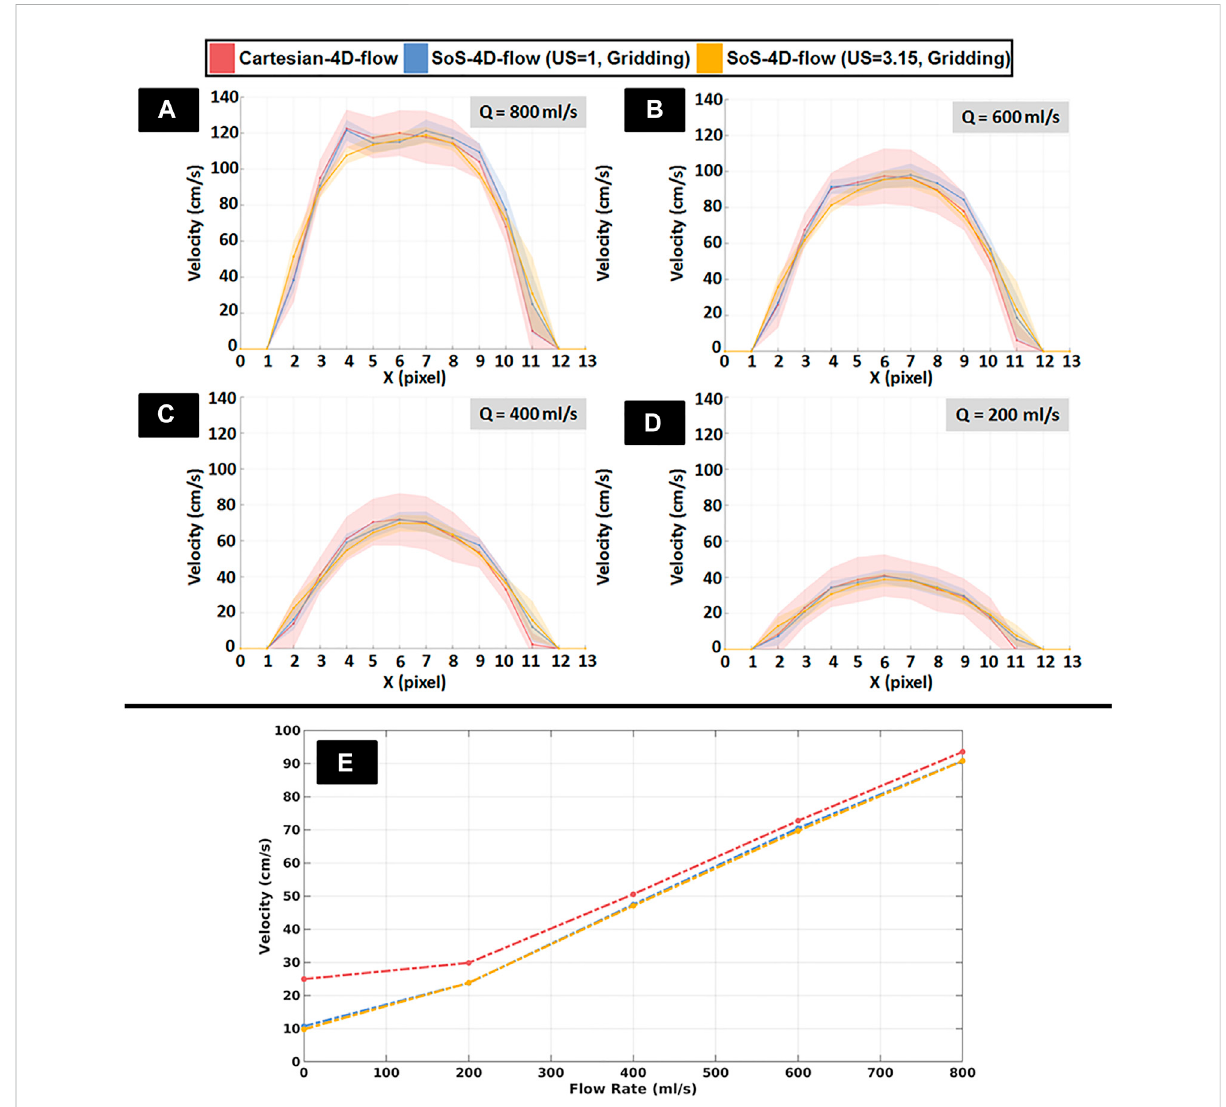
FIGURE 4 (A – D) Representativespatialvelocitypro fi lesperpendiculartothelongaxisofarepresentativetube(solidlines:meanvelocity,shades:standard deviation) obtained from fully sampled SoS-4D- fl ow, undersampled SoS-4D- fl ow with an undersampling (US) factor of π , and Cartesian-4D- fl ow data at different pump speeds (Q) ranging from 200 to 800 ml/s. Each unit in pixel along the X axis represents 300µm. (E) Representative plot showing the velocity values obtained by the fully-sampled SoS-4D- fl ow, undersampled SoS-4D- fl ow, and the fully-sampled Cartesian-4D- fl ow technique at different fl ow rates (i.e., pump